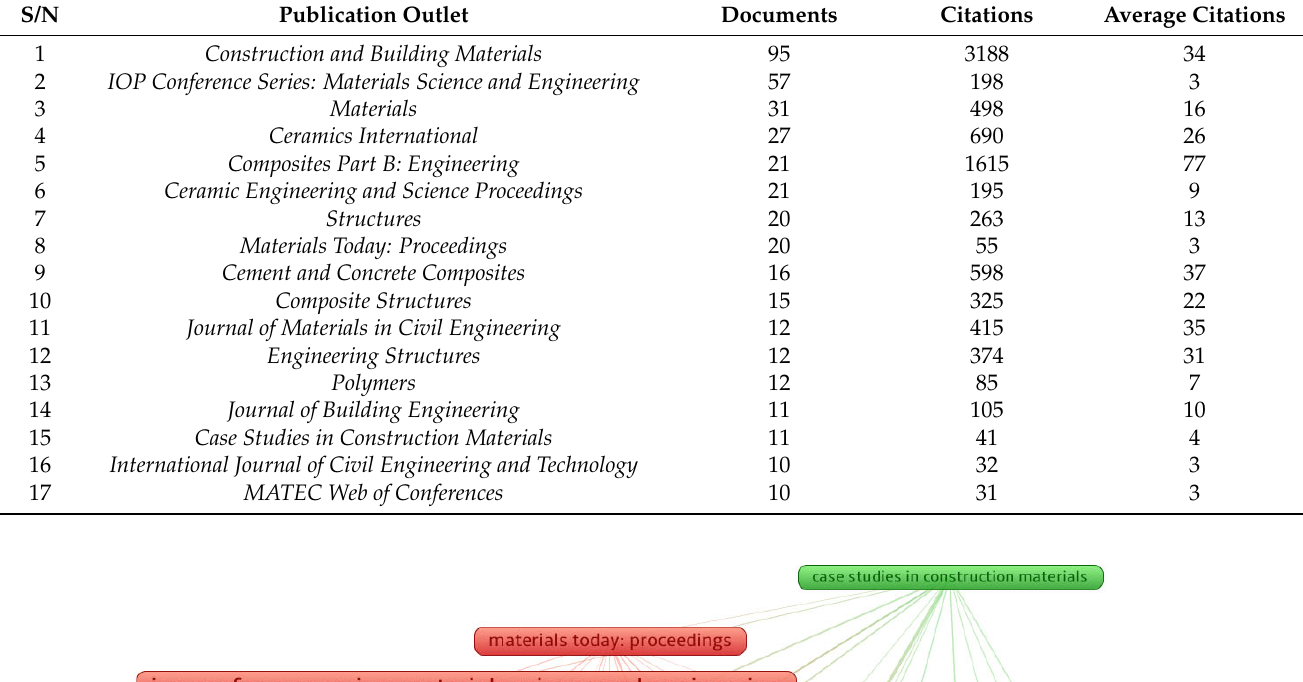
Table 1. Most contributing publication outlets in FRGP studies.